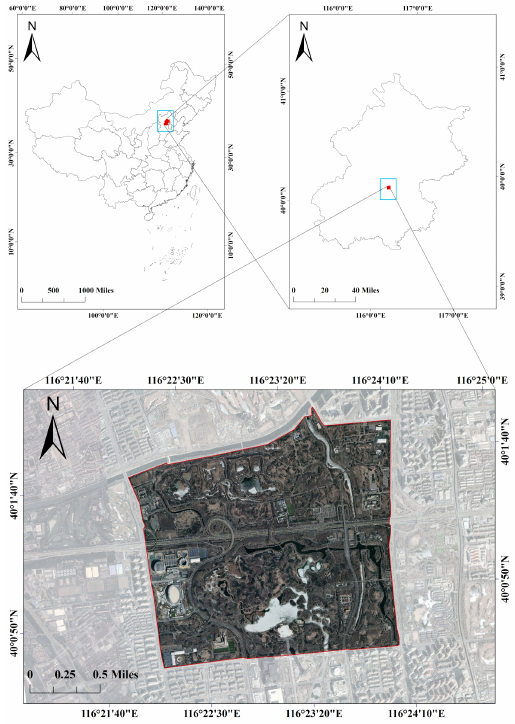
Figure 1. Map showing the experimental plot area—The Olympic Forest Park. Table 1. Information on control site and plots of multi-layered vegetation communities (trees + shrubs + grasses) in forest parks with different canopy